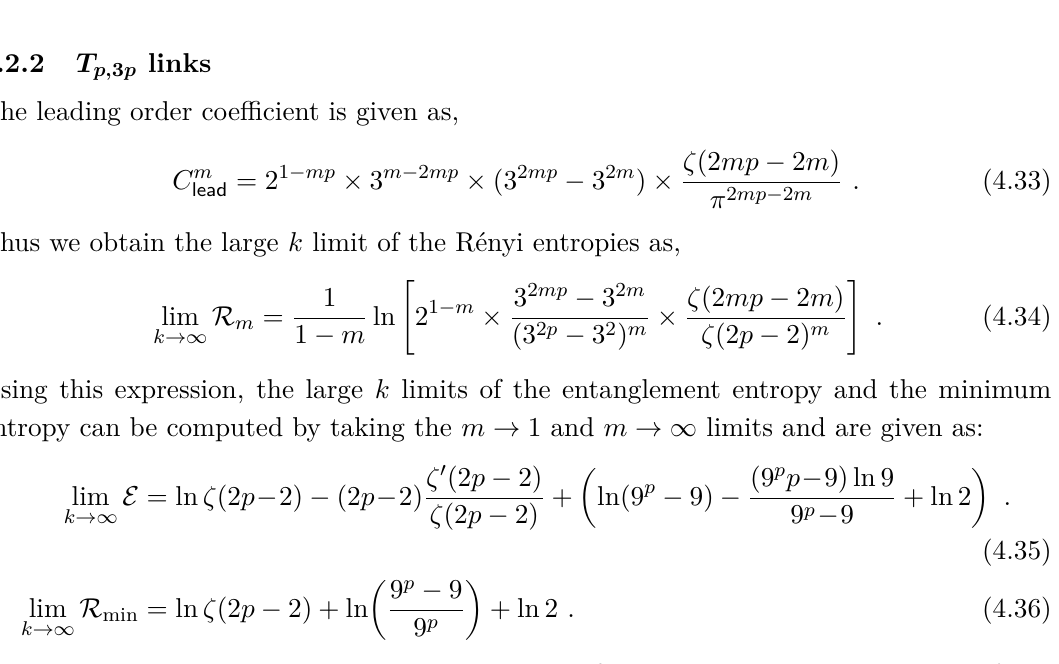
Figure 6. The variation of the SU (2) k entanglement entropy with k for T p, 2 p torus links. The entropy shows two distinct patterns depending upon whether k is even or odd. As k becomes large, the two patterns converge to a unique value given in (4.31). The corresponding numerical values up to two decimal places have been indicated against each